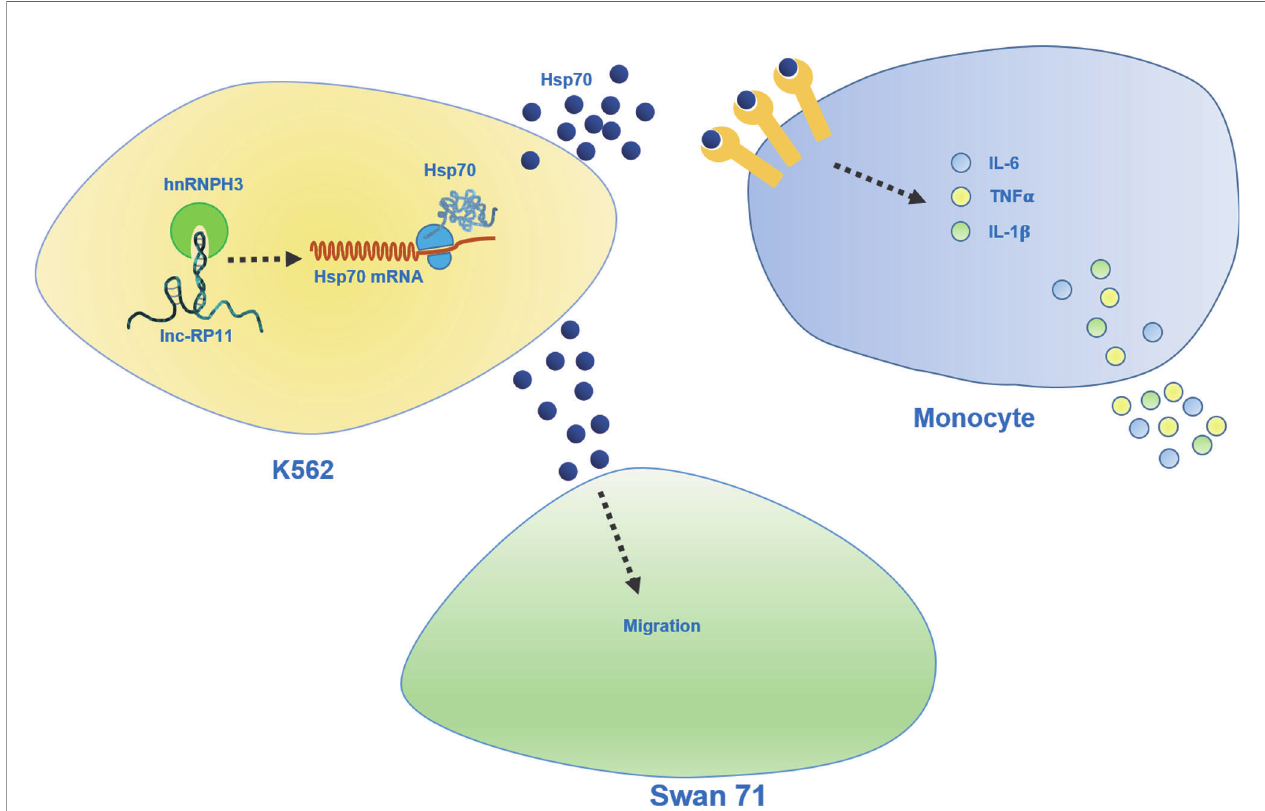
FIGURE 6 | Schematic diagram of role of RP11-115N4.1. RP11-115N4.1 bound to HNRNPH3 and increased the protein level of HSP70 in K562 cells. HSP70 released outside the cell induced the upregulation of the in fl ammatory factor IL-6, IL-1 b and TNF- a of monocytes and inhibited the migration of Swan 71. The black dashed line represents an unknown